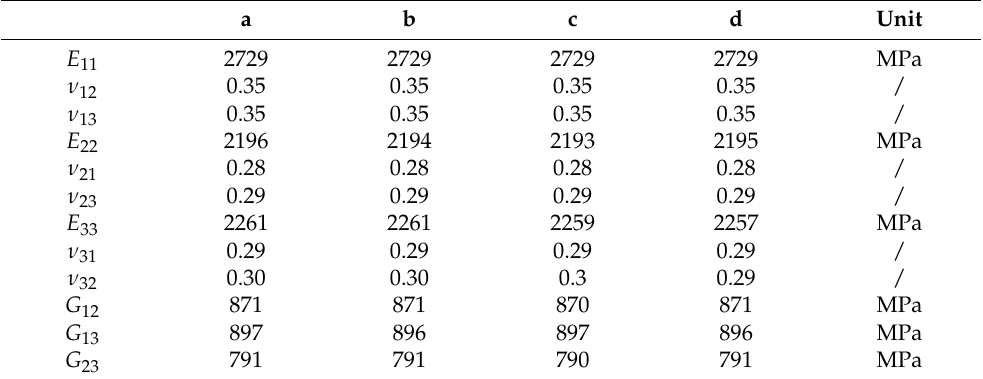
Table 4. Mechanical properties for all the RVE